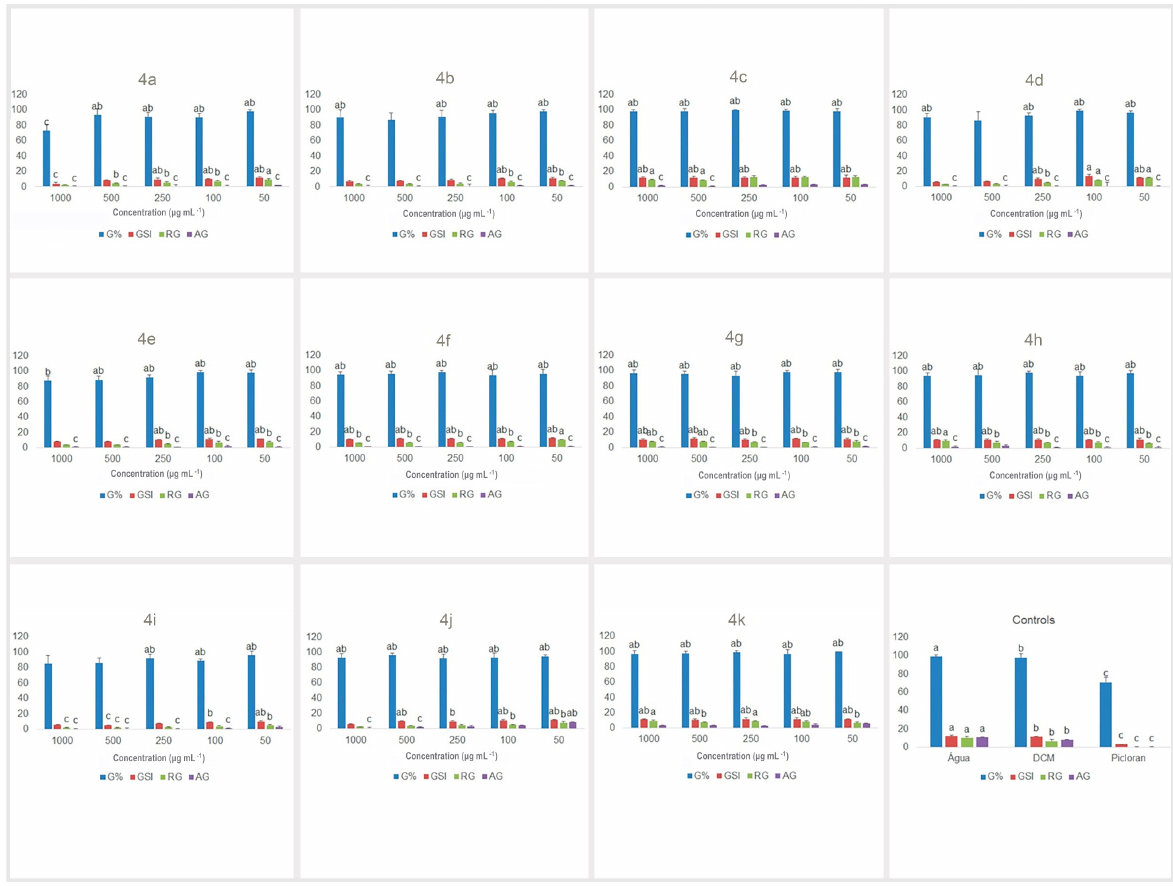
Figure 2. Phytotoxicity evaluation of triazoles 4a-4k . The effects of the compounds were assessed on the plant model Lactuca sativa at five concentrations. Positive control was picloram and negative controls corresponded to dichloromethane and water. The G% = germination percentage; GSI = Germination Speed Index; RG = Root Growth; AG = Aerial Growth. The means followed by the letter a were equal to the negative control water, those followed by the letter b were equal to the negative control dichloromethane and those followed by the letter c were equal to the positive control picloram (0.1%) according to the Dunnett test ( p